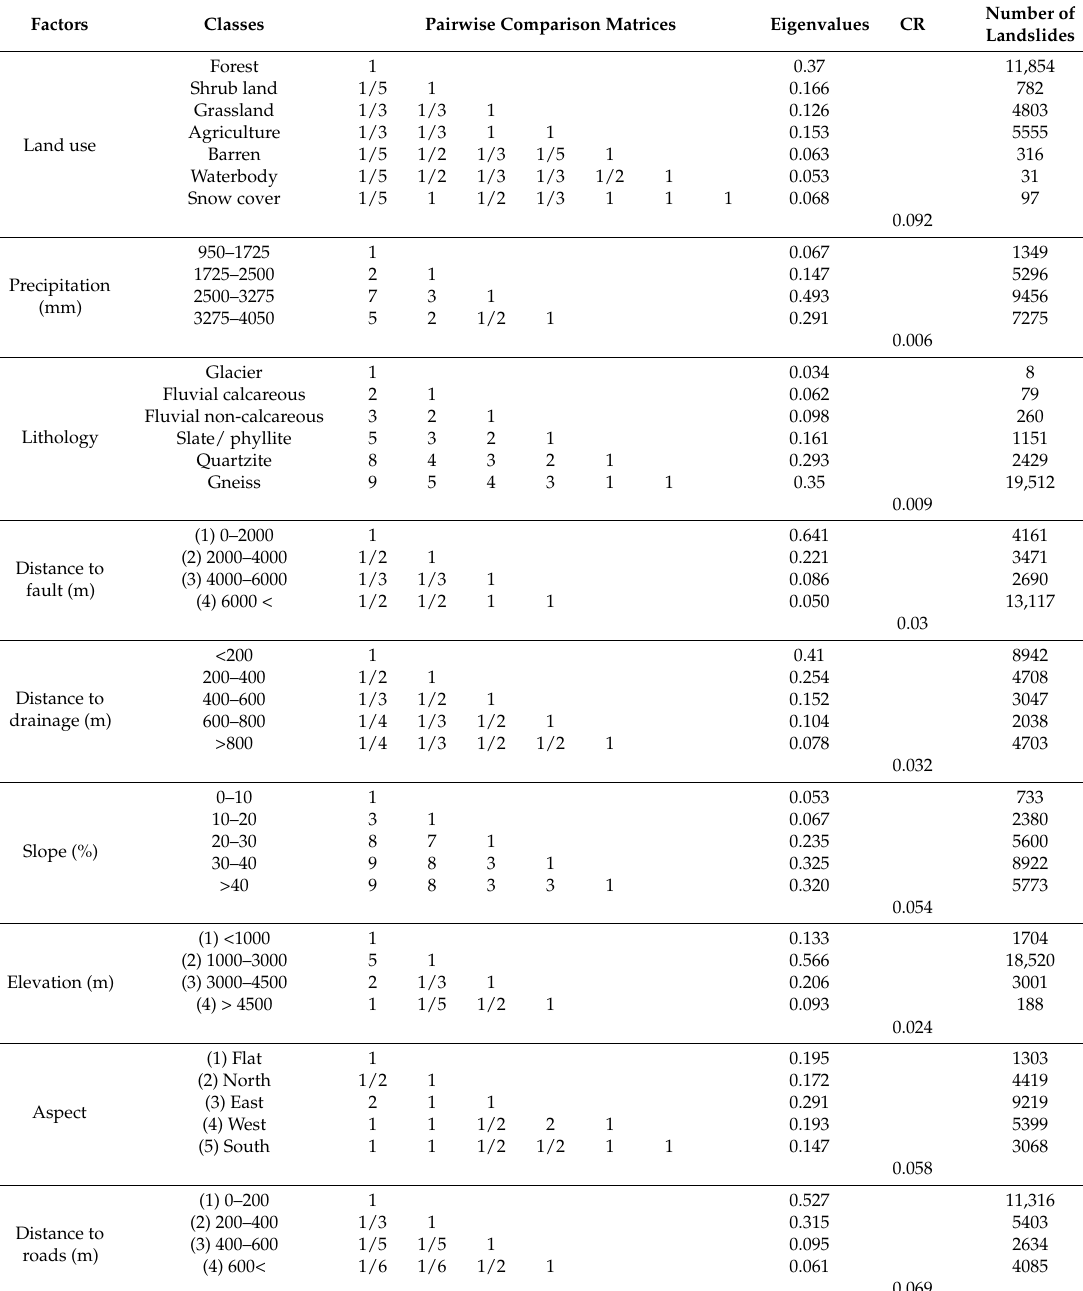
Table 4. Pairwise comparison matrix for the analytical hierarchy process (AHP)